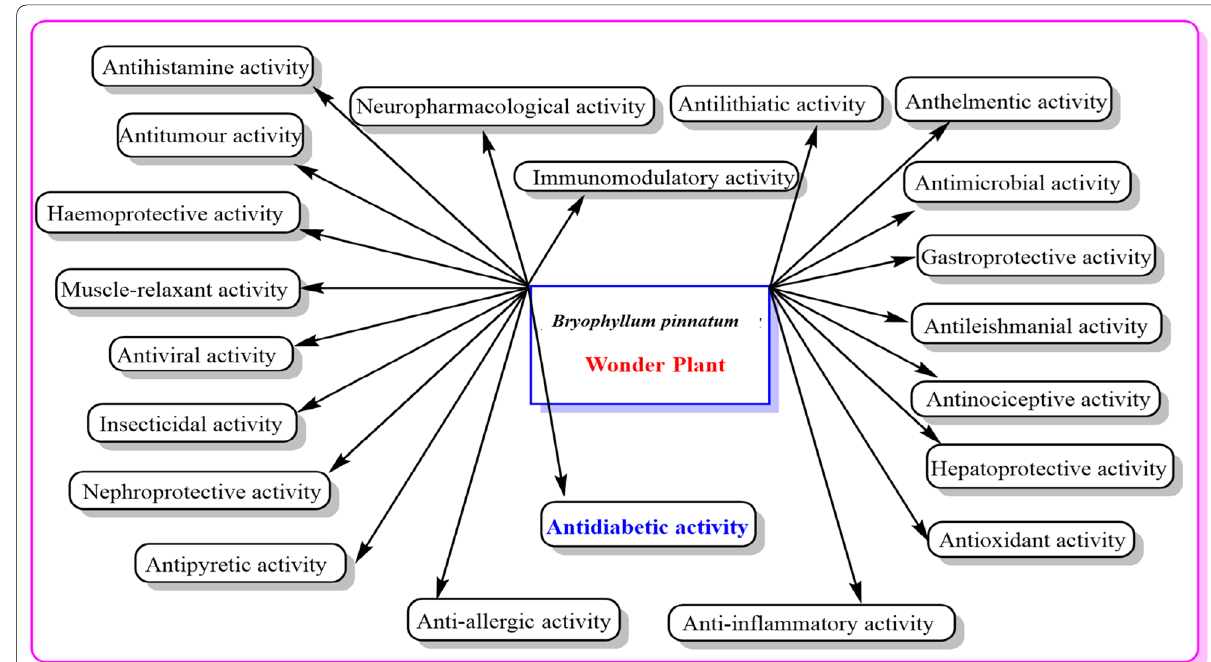
Fig. 2 Pharmacological activities of B. pinnatum , also known as “wonder